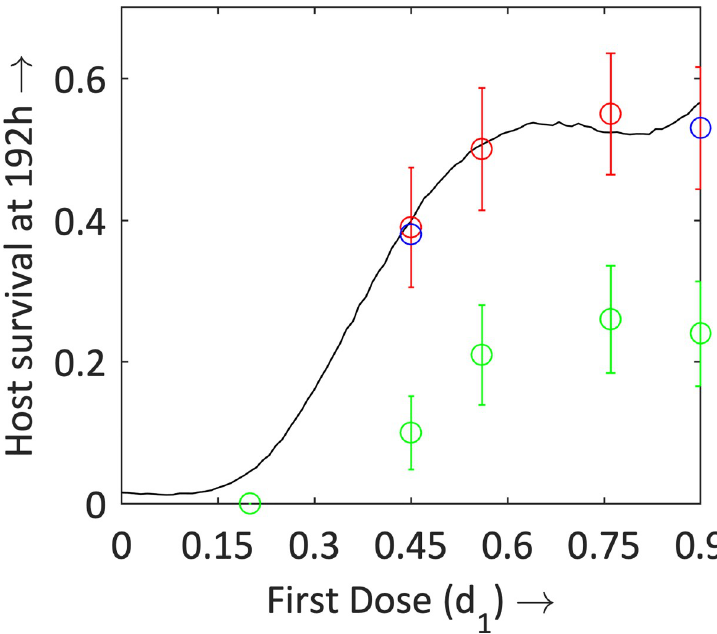
Fig 3. Survival rates at 192 h for various first doses, d 1 ; where the second dose is (0.9 − d 1 ). The mathematical model results are in black; blue circles represent the initial biological experimental data (Table 2), and green circles are the additional biological experiments (Table 3). Red circles represent the normalised data from Table 3 (with each of the four points increased by 0.28). (The model runs for these solutions were increased to 10000 to confirm the accuracy of the